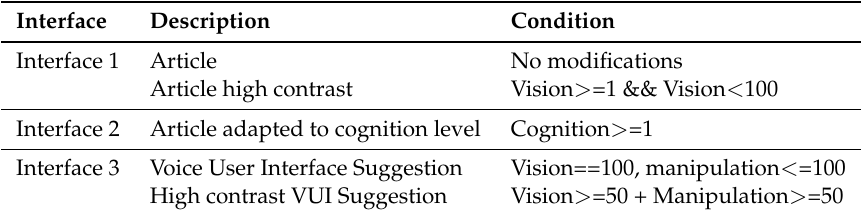
Table 6. Interfaces